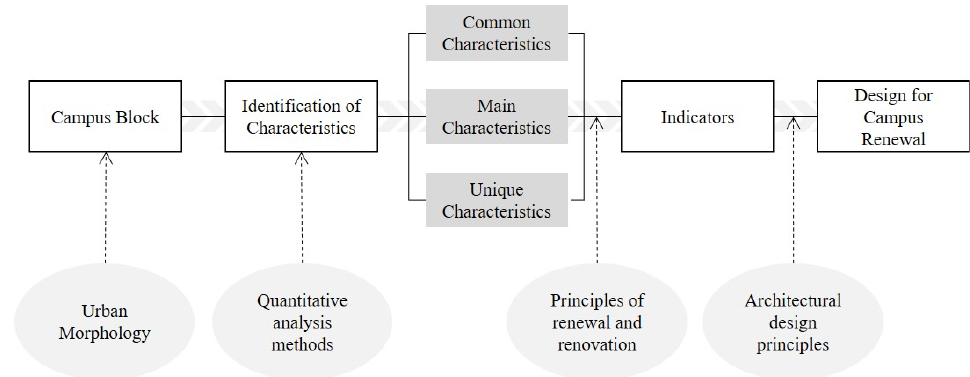
Figure 13. The evolution of the indicators.